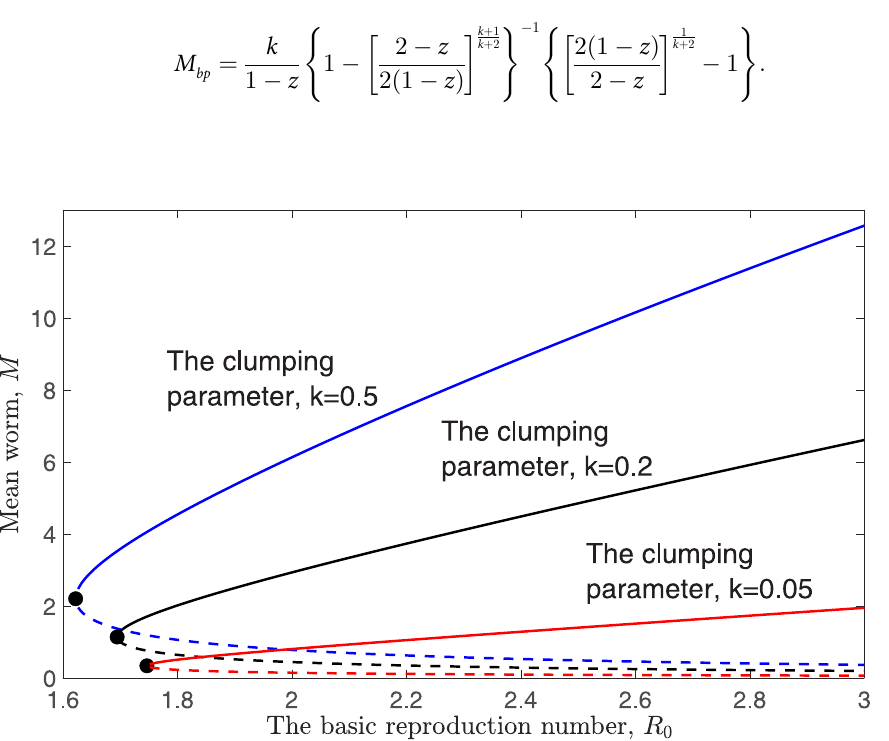
Fig 1. Numerical solutions of the endemic equilibria M eq as a function of R 0 with different k values, fixing z =